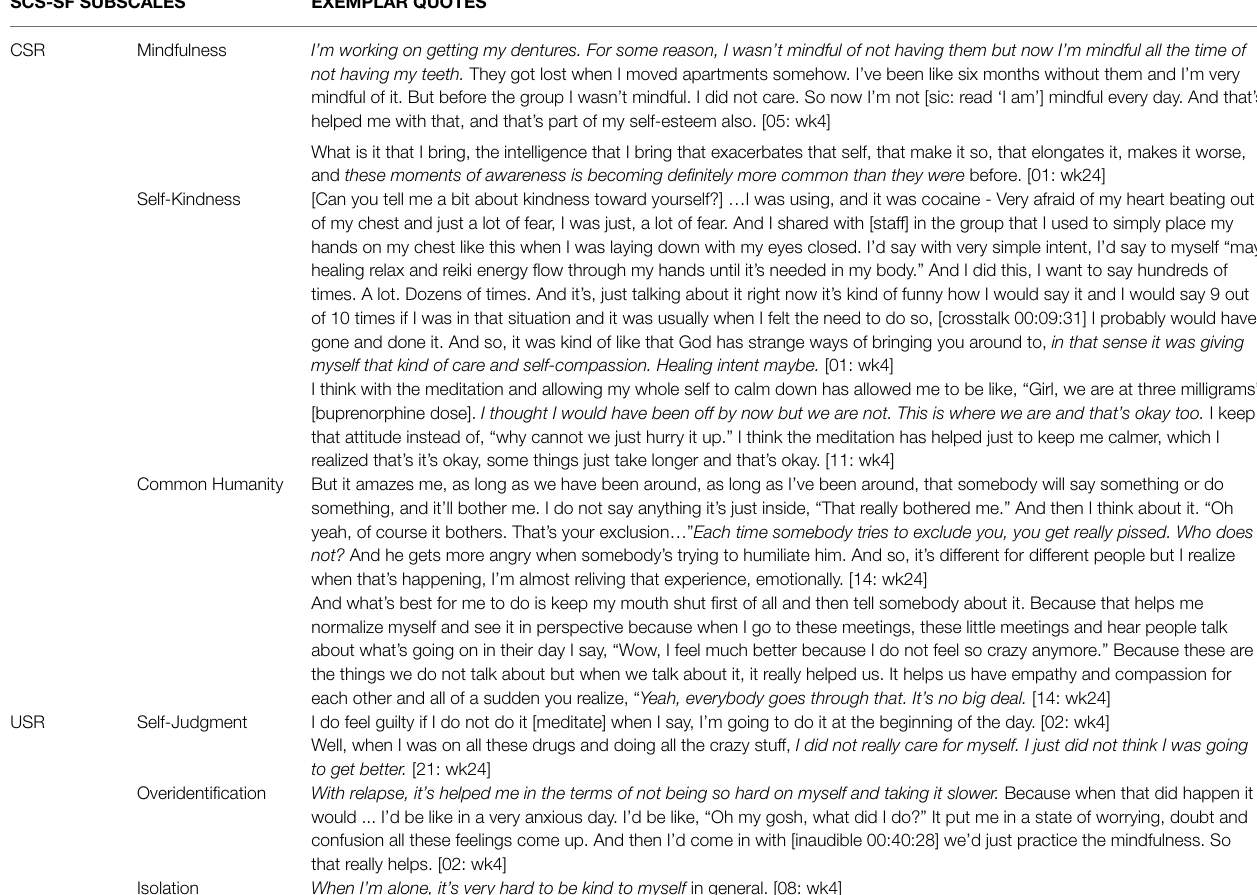
TABLE 3 | Exemplar quotes: evidence supporting subscale representation in the dataset. SCS-SF